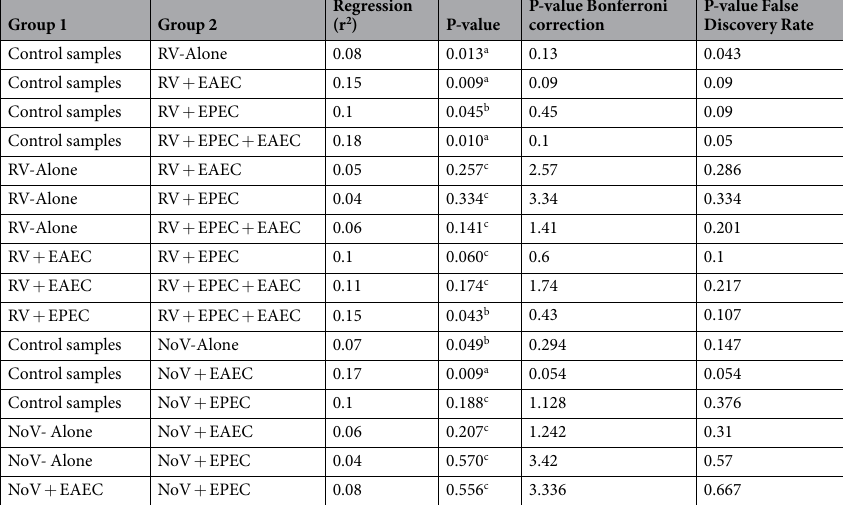
Table 2. Pairwise differences: post-hoc test of gut microbiome in healthy children and AGE (RV and NoV) infected children. RV- rotavirus; EAEC- Enteroaggregative E. coli ; EPEC- Enteropathogenic E. coli ; NoV- norovirus. a statistically highly significant between control samples and AGE infection (p < 0.01); b statistically low significant between control samples and AGE infection (p < 0.05); c statistically not significant within AGE (p > 0.05).